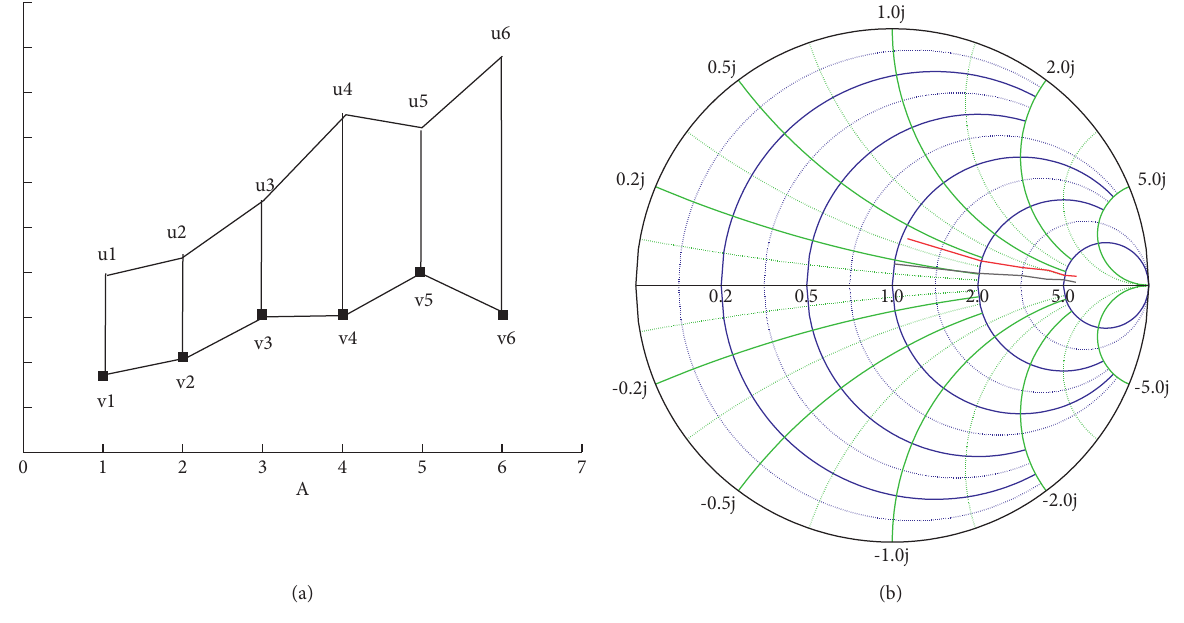
Figure 6: Schematic diagram of the grey